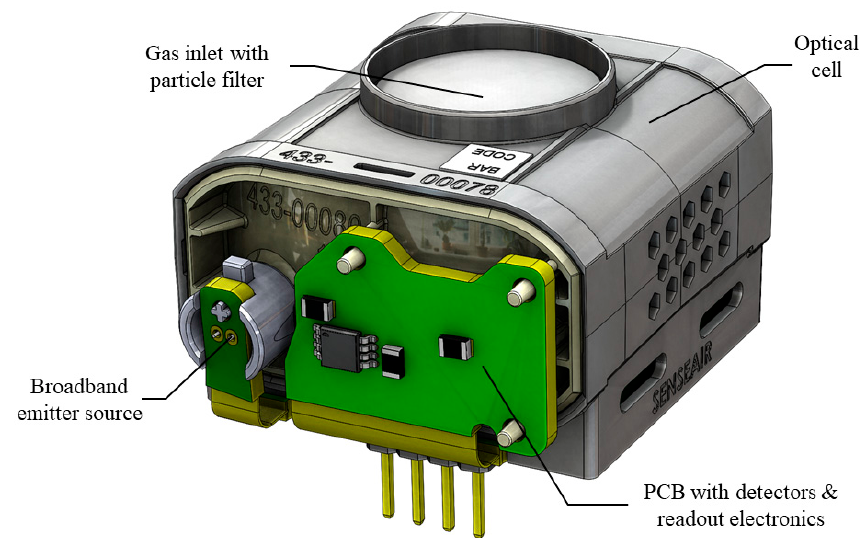
Figure 3. CAD drawing of the Sensor Core containing the optical cell and the complete readout electronics to digitize the reading of the three detectors from the Long-, Medium- and Short-Pass Length. To avoid contamination from dust or particles, a filter is installed on top of the optical cell.